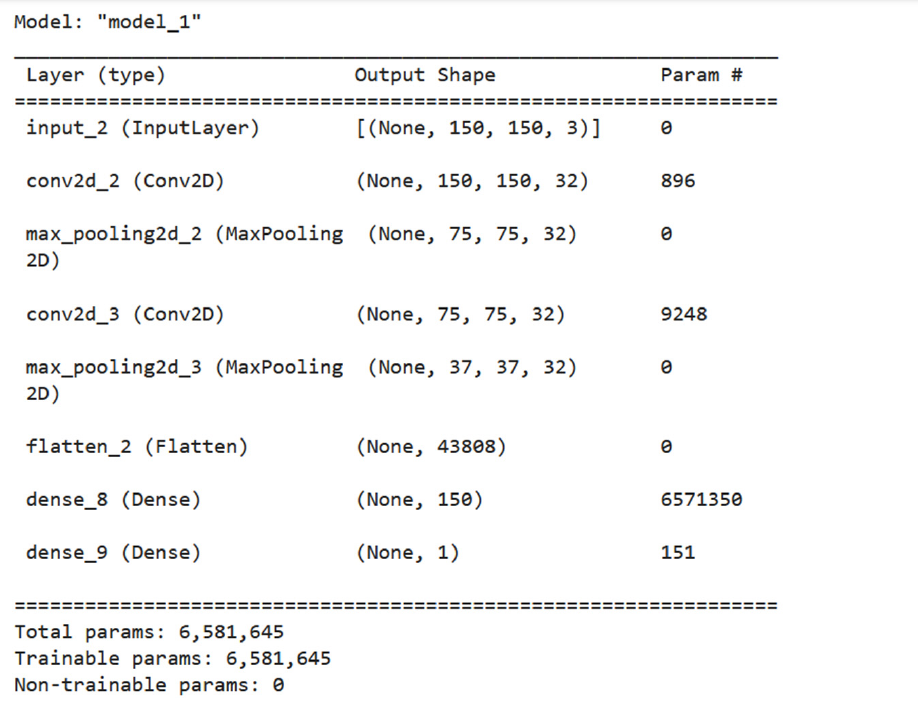
Figure 5. Summary of the proposed model for binary classification.